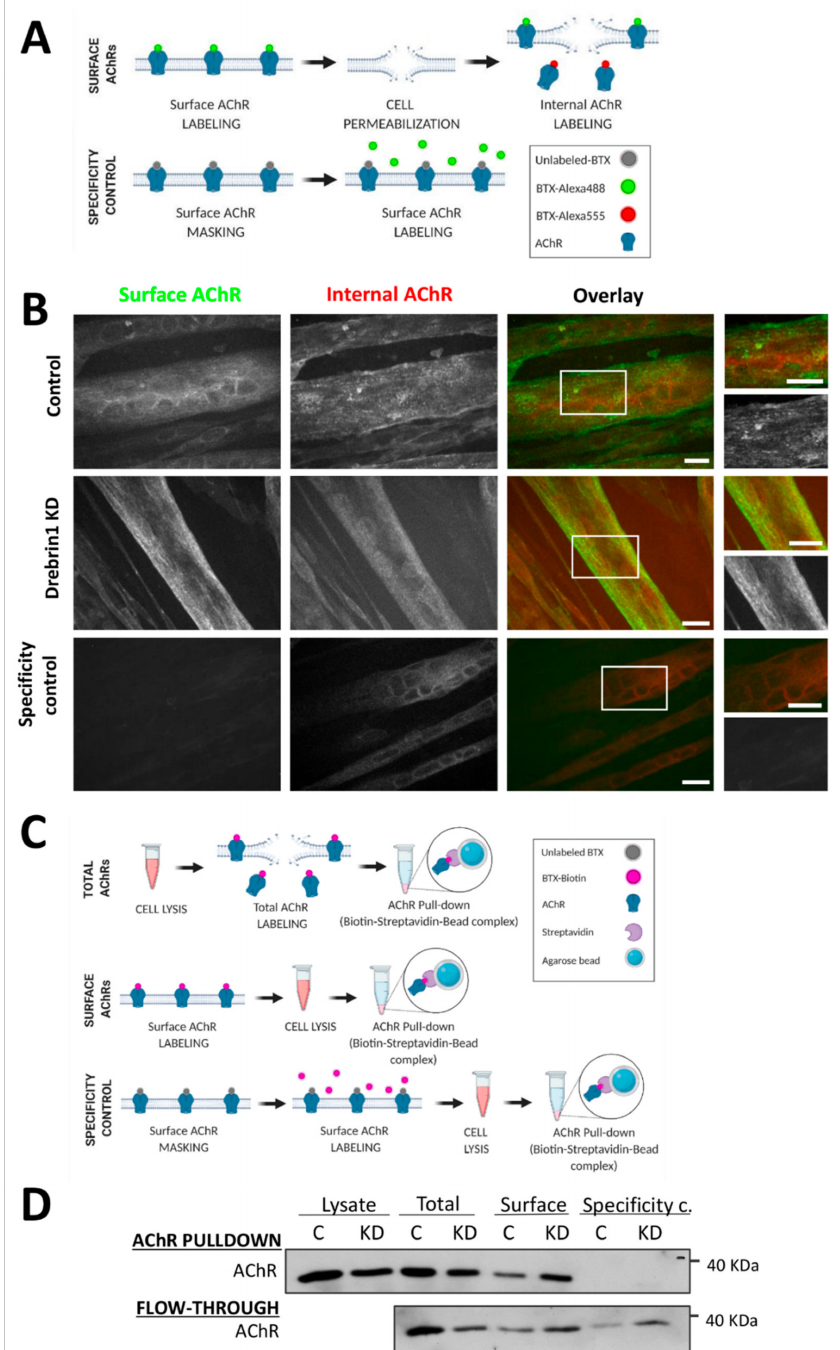
Figure 7. Cell surface delivery of AChRs is not affected by drebrin knockdown. ( A ) Schematic illustration of labeling surface and internal AChRs. ( B ) Surface AChRs (green) and internal AChRs (red) labeled with BTX-488 and BTX-555, respectively, in drebrin-depleted and control C2C12 myotubes transfected with non-targeting siRNA. Specificity control was performed by saturating myotubes with unlabeled BTX and subsequent labeling with BTX-488. Scale bars—20 µ m. ( C ) Schematic illustration of AChR pull-down from drebrin-depleted and control myotubes. Specificity control was performed by saturating myotubes with unlabeled BTX and subsequent labeling with BTX-Biotin. ( D ) Pull-down of surface and total AChRs from the lysates of C2C12 myotubes after drebrin knockdown. AChR pulldown—immunoprecipitation of total and surface AChRs with BTX-Biotin and NeutrAvidin agarose beads. Flow-through—lysate after BTX-Biotin- NeutrAvidin complex pull-down. C—control myotubes transfected with non-targeting siRNA, KD—myotubes transfected with Dbn1-siRNA1. Illustrations were created with